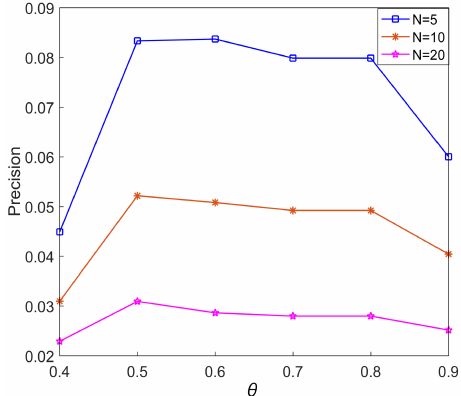
Figure 2. Parameter θ setteing for Tokyo